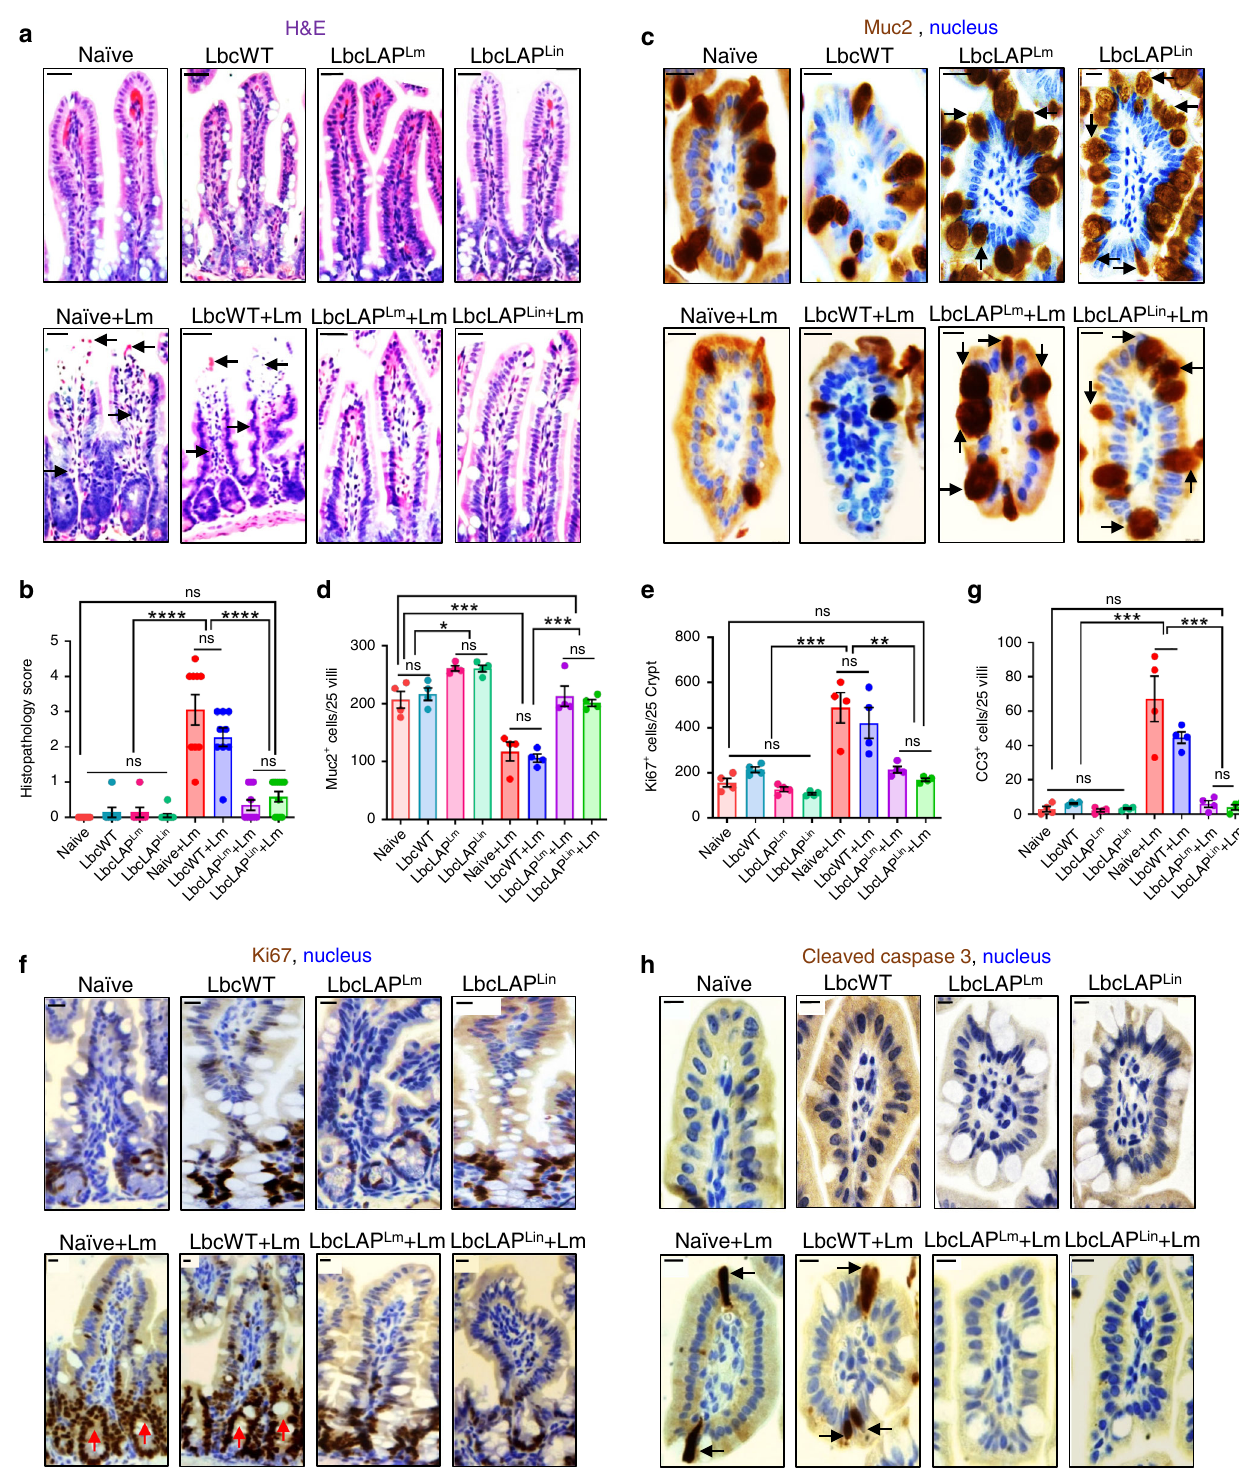
BLP promotes immunomodulation to protect the host from Lm infection . Next, we assessed whether the BLP strains mod- ulate the intestinal mucosal in fi ltration of the immune cells in the underlying lamina propria by immunostaining. Relative to naive uninfected mice, we observed a signi fi cant increase in the num- bers of in fi ltrated F4/80 + macrophages (~225%, Supplementary Fig. 9a), CD3 + T cells (~120%, Supplementary Fig. 9b) and CD8 + T cells (~2000%, Supplementary Fig. 9c) in the lamina propria of naive or LbcWT-treated mice at 48 h post Lm challenge, in line